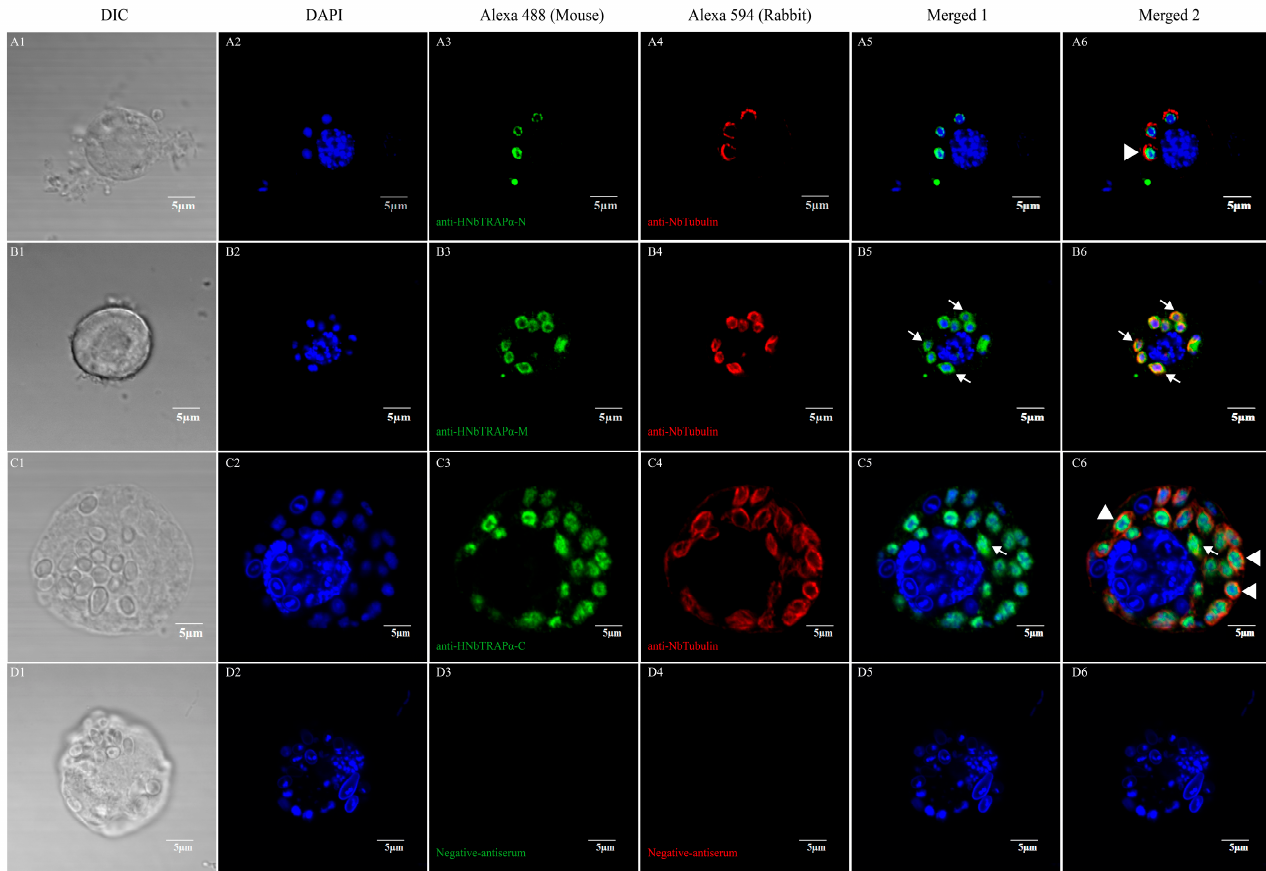
Figure 4. Indirect immunofluorescent assay of HNbTRAP α in developing stages within Sf9 cells. In developing stages, HNbTRAP α locates around or in the nucleus. A1~A6 showed the nuclear membrane distributed HNbTRAP α , which was detected by mouse antiserum against the N terminal (1–232 aa) of HNbTRAP α . B1~B6 showed the simultaneous cytoplasm and nucleus membrane distribution of HNbTRAP α through the mouse antiserum against the central region (233–327 aa). C1~C6 were detected by the mouse antiserum against the C terminal (569–742 aa) of HNbTRAP α . D1~D6 were negative controls, which used negative antiserums as the primary antibody. The cytoplasm was labeled by the NbTubulin- β antiserum, and the cell nucleus was stained by DAPI. The white arrows indicate HNbTRAP α distributing in both the cytoplasm and perinuclear region of N. bombycis , as for the merged green and red fluorescent presented yellow. The white arrowheads indicate the perinuclear region distributed HNbTRAP α